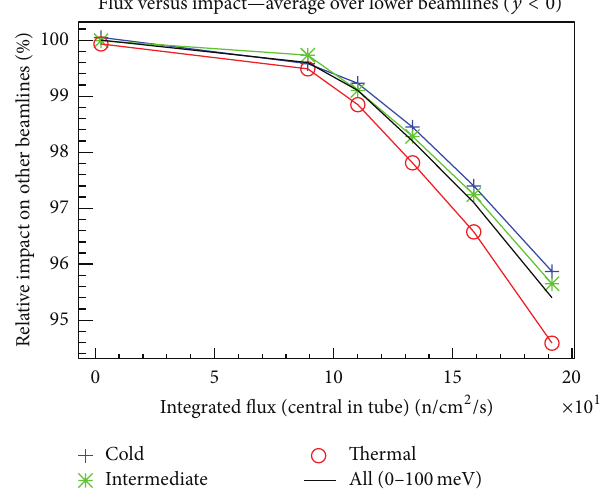
Figure 3: Relation between cold, intermediate, and thermal flux in the lower cold/thermal beamlines versus the flux available for UCN, central in the through-going tube. The black curve shows the (unweighted) average between the cold, intermediate, and thermal curves. Each point corresponds to a specific vertical position of the through-going tube.